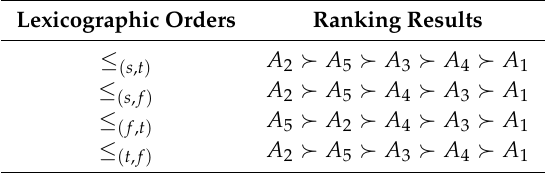
Table 7. Ranking results given by different lexicographic orders in Case